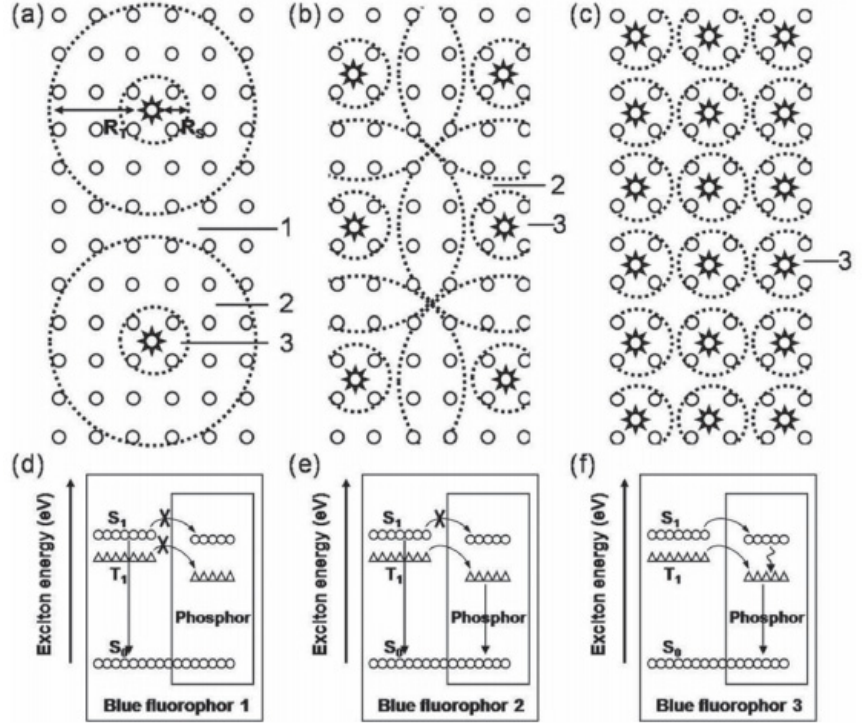
Figure 24. Decay channels for singlets and triplets on the host fluorescent molecules with the changing guest concentration. Reproduced from Reference [211].